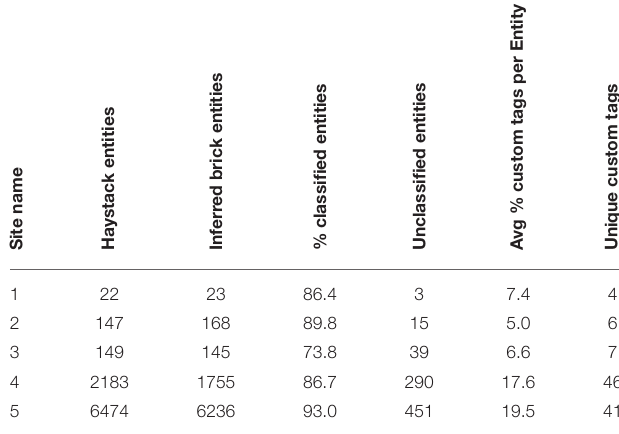
TABLE 3 | The completeness of the migration tool against five Brick reference models in terms of the unique classes and relationships in the source model.